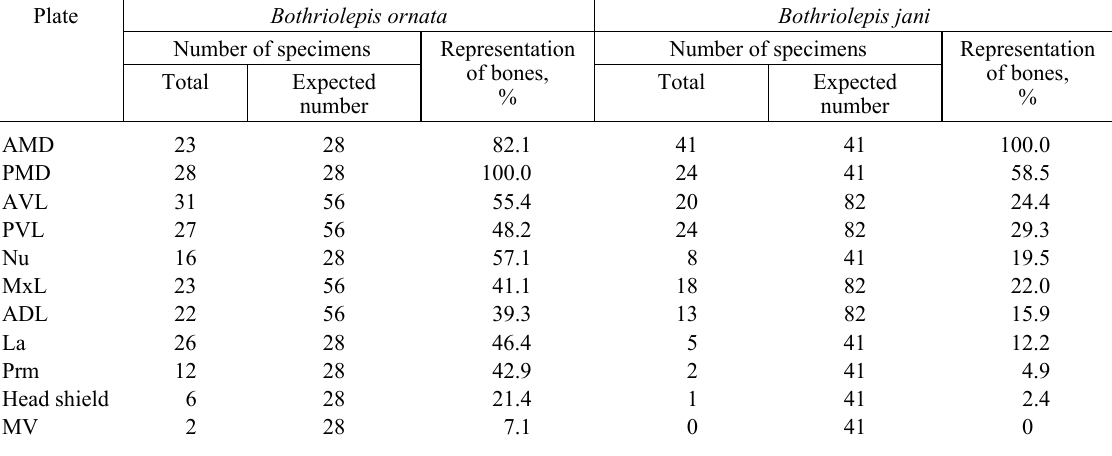
Table 4. The representation of some skeletal elements belonging to Bothriolepis ornata and B. jani , based on material of 2009 and 2010 Bothriolepis ornata Bothriolepis jani Number of specimens Number of